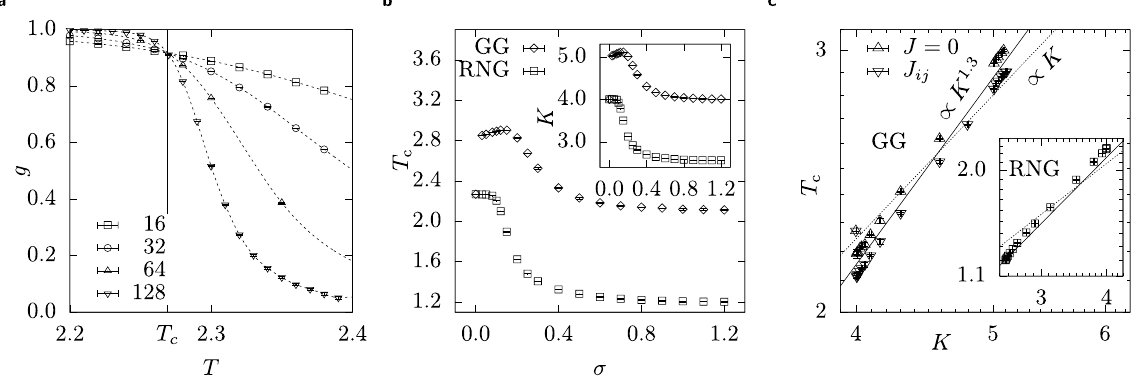
Figure 4. ( a ) Critical temperatures T c are obtained by finding the intersections of the Binder cumulants g for different system sizes L . ( b ) T c as a function of σ . The inset shows the average degree K as a function of σ . ( c ) T c as a function of K on a log-log scale. The upper curve is for an ensemble where all edges have weight J = 1 and the lower curve for length dependent weight J ij . The inset shows the same for the RNG. It is clearly visible that the functional relation T c ( K ) is not linear (dotted line) as predicted by the Bethe approximation, but rather a power law T c ∝ K b with an exponent of b ≈ 1.3 (solid line).